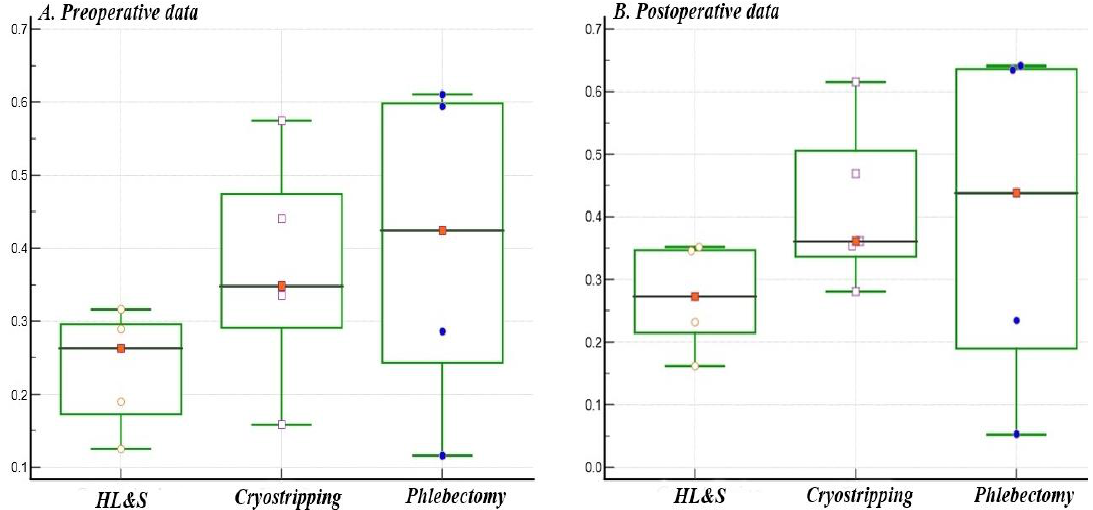
Figure 1. Data of the three groups compared preoperative ( A ) and postoperative ( B ). A graphical increase in quality of life (QoL) was observed in all three groups postoperatively.